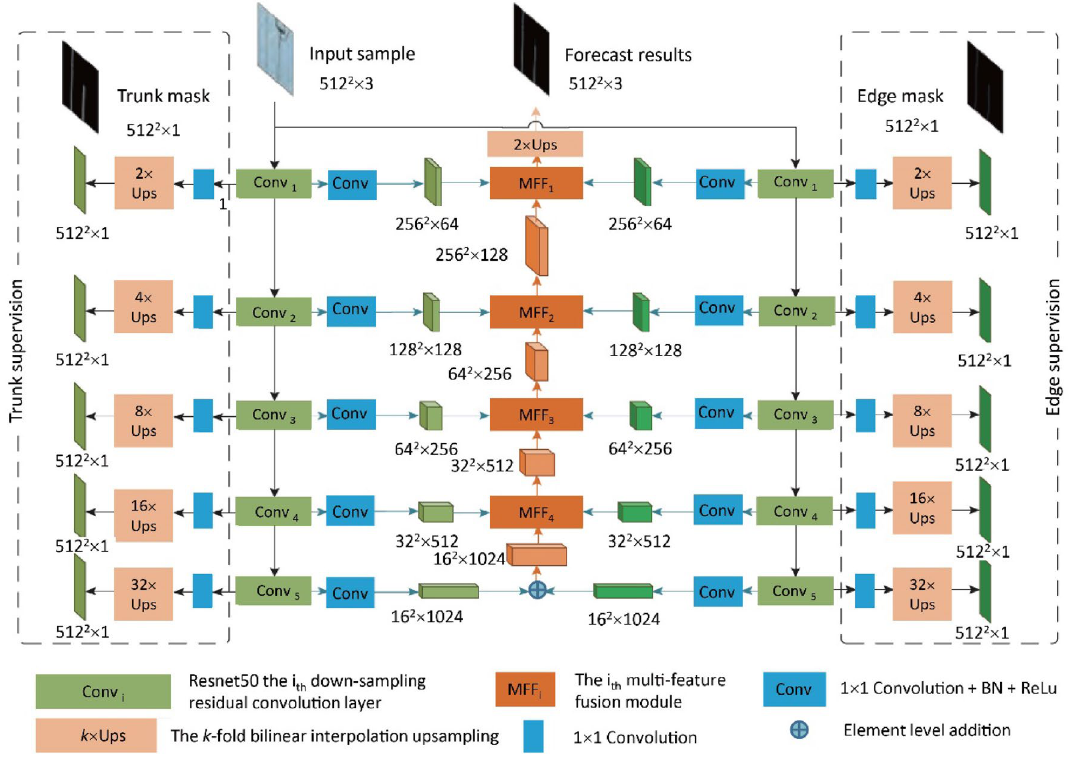
Fig. 5 Multi-linear feature enhancement network structure